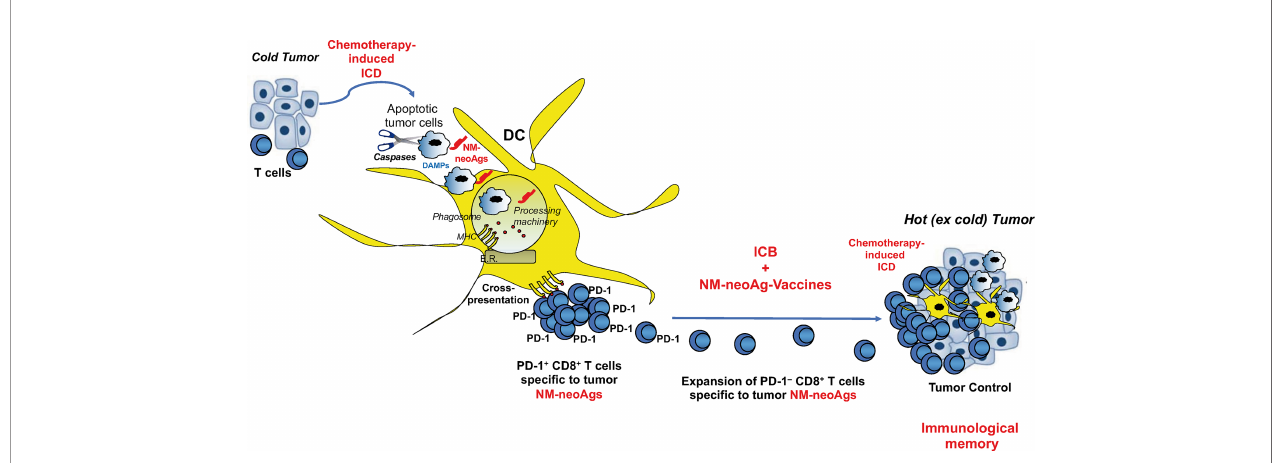
FIGURE 3 | Combination of immunogenic cell death, non-mutated neoantigen-based vaccination, and ICB in tumor immunotherapy. Immunogenic cell death (ICD) by chemotherapy unveils both danger signals (activating DCs) and non-mutated neoantigens (NM-neoAgs) in apoptotic tumor cells that are ef fi ciently phagocytosed by DCs. NM-neoAgs derive by caspase cleavage of a variety of tumor antigens, are ef fi ciently processed and (cross-)presented by DCs in form of peptides on MHC molecules (67) to T cells. CD8 + T cells proliferate and further expand in response to ICB treatment (anti-PD-1 therapy), providing improvement of effector function and conversion of PD-1 + T cells into PD-1 – T cells. Effector CD8 + T EM cells can migrate into the tumor microenvironment and be further boosted by NM-neoAgs derived from chemotherapy-induced apoptotic tumor cells cross-presented by tissue DCs: CD8 + T EM/EMRA cells provide tumor control through the by-stander effect of strong in fl ammatory cytokines and the recruitment of other T cells and innate immune cells (macrophages, neutrophils, natural killer cells, … ). This scenario is supported by the evidence showing that NM-neoAg-speci fi c CD8 + T cells are signi fi cantly represented in NSCLC patients previously submitted to chemotherapy, increase in their frequency upon ICB therapy, and correlated with overall survival (67). The addition of therapeutic NM-neoAg-based vaccines may improve T cell memory and tumor immunity, as well as convert cold into hot